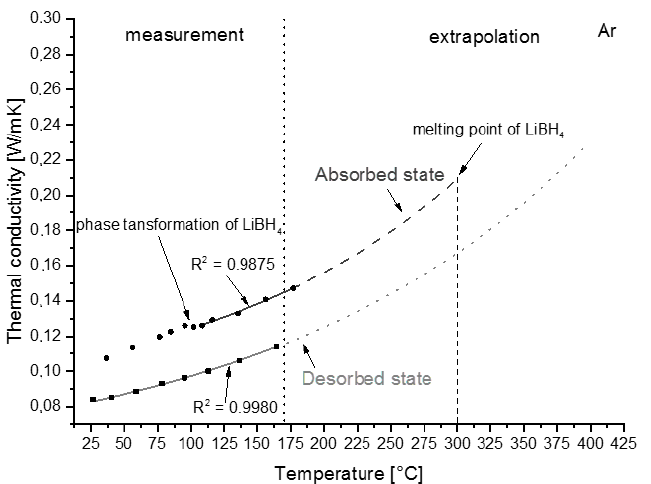
Figure 5. Thermal conductivity plotted against temperature from room temperature to 175 °C in Ar atmosphere for materials in absorbed (LiBH 4 /MgH 2 ) and desorbed (LiH/MgB 2 ) state together with an extrapolation for T > 175 °C.